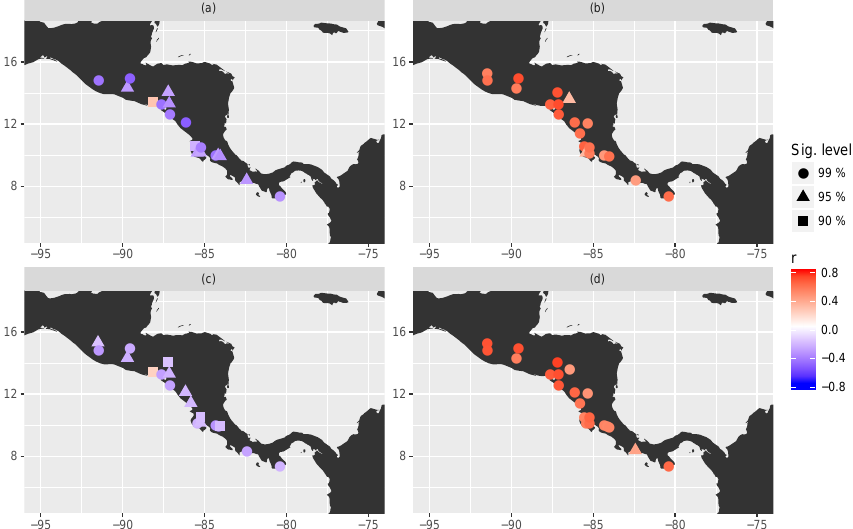
Figure 6. Top Pearson correlation between MSD intensity and (a) CLLJ index and (b) Niño 3.4 indexes. Bottom the same metric but for the MSD magnitude with (c) CLLJ and (d) Niño 3.4 indexes. Niño 3.4 index is taken for June. The CLLJ index is estimated from the daily time series, using the definition by Amador (2008) for